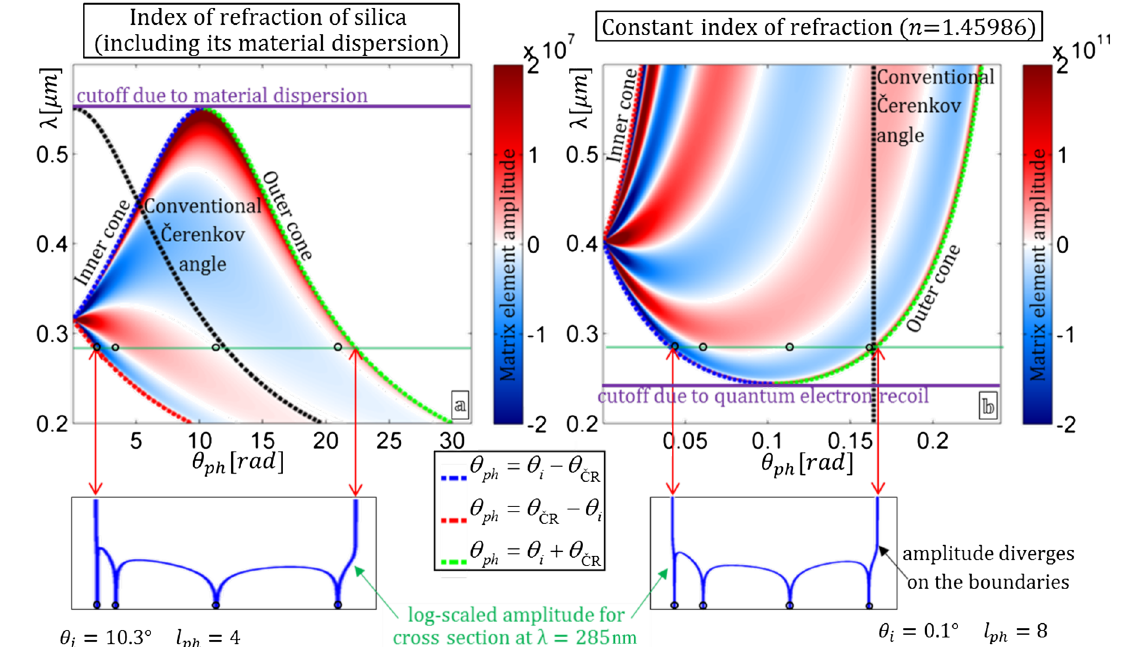
FIG. 2. Matrix-element amplitudes for the Č R process, as a function of the photon wavelength λ and emission spread angle θ ph . The color map shows the spatial part of the matrix element [Eq. (3)] that vanishes outside of the permitted zone, bounded by the blue, red, and green dashed curves. Along these curves, the amplitude diverges; thus, we use a saturated color scale, with darker colors corresponding to higher transition amplitudes. The divergences are highlighted by the cross-section plots below the maps, also showing the nodal lines of zero amplitude (marked by black circles) between high amplitude “ stripes. ” These distinct stripes depend on the OAM [ l ph ¼ 4 , 8 in (a) and (b)], showing the coupling between the OAM and preferred emission angles inside the permitted zone (which is independent of angular momentum). The black dashed curve denotes the angle of the conventional Č R [Eq. (1a)], changing with λ in (a) because of the silica dispersion. The spectral cutoffs are marked by solid purple lines — beyond these wavelengths, no photons are ¼ 0 ; hence θ ¼ θ emitted. At the points tangential to this line, θ ˇ ph i [equals 10.3° in (a) or 0.1° in (b)]. The 4-order-of-magnitude CR difference between the two panels results from the 2-order-of-magnitude difference in θ i , and the 2-order-of-magnitude difference in θ ph (as shown by the horizontal axes), both of which contribute to the calculation of the area S Δ . All figures have β ¼ 0 . 685 and the refractive index of silica including its material dispersion (a) or constant n ¼ 1 . 45986